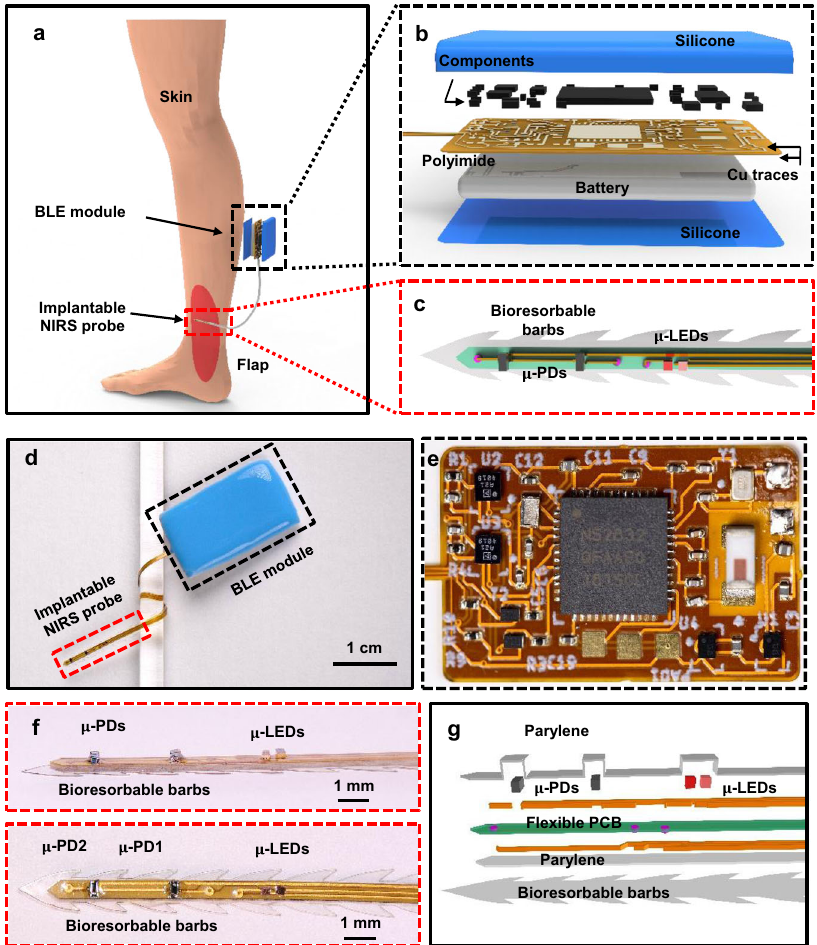
Fig. 1 Wireless, implantable near-infrared spectroscopic (NIRS) probing system for local-tissue oximetry. a Schematic illustration of a NIRS probe and wireless module depolyed in a microsurgically transferred free muscular fl ap. b Exploded view of the wireless communication module based on Bluetooth Low Energy (BLE) technology. c Top-down view of the sensing probe featuring the bioresorbable barbs and sensing units. d Image of a wireless NIRS system with sensing probe wrapped around a plastic tube to highlight its mechanical fl exibility. e Enlarged view of the wireless communication module supported on a fl exible printed circuit board. f Images of the sensing probe, top: side view, bottom: top-down view. g Exploded view of the sensing probe with a conformal layer of parylene for encapsulation and a bioresorbable base layer consisting of distributed bioresorbable barbs for temporarily anchoring the probe to the surrounding soft